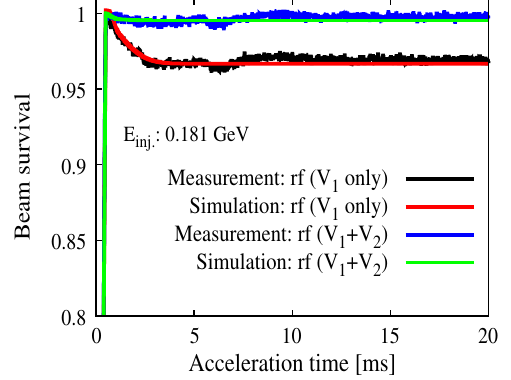
FIG. 7. Simulated and measured results of beam survival with strong and weak space charge controlled by rf patterns and longitudinal injection painting for beam power of 0.375 MW. The space-charge-induced beam loss is as high as 3% when applying only V 1 , but it can be well mitigated by adding V 2 and applying longitudinal injection painting. The time structure of beam intensity loss in the simulation is shown to be consistent with the measurement